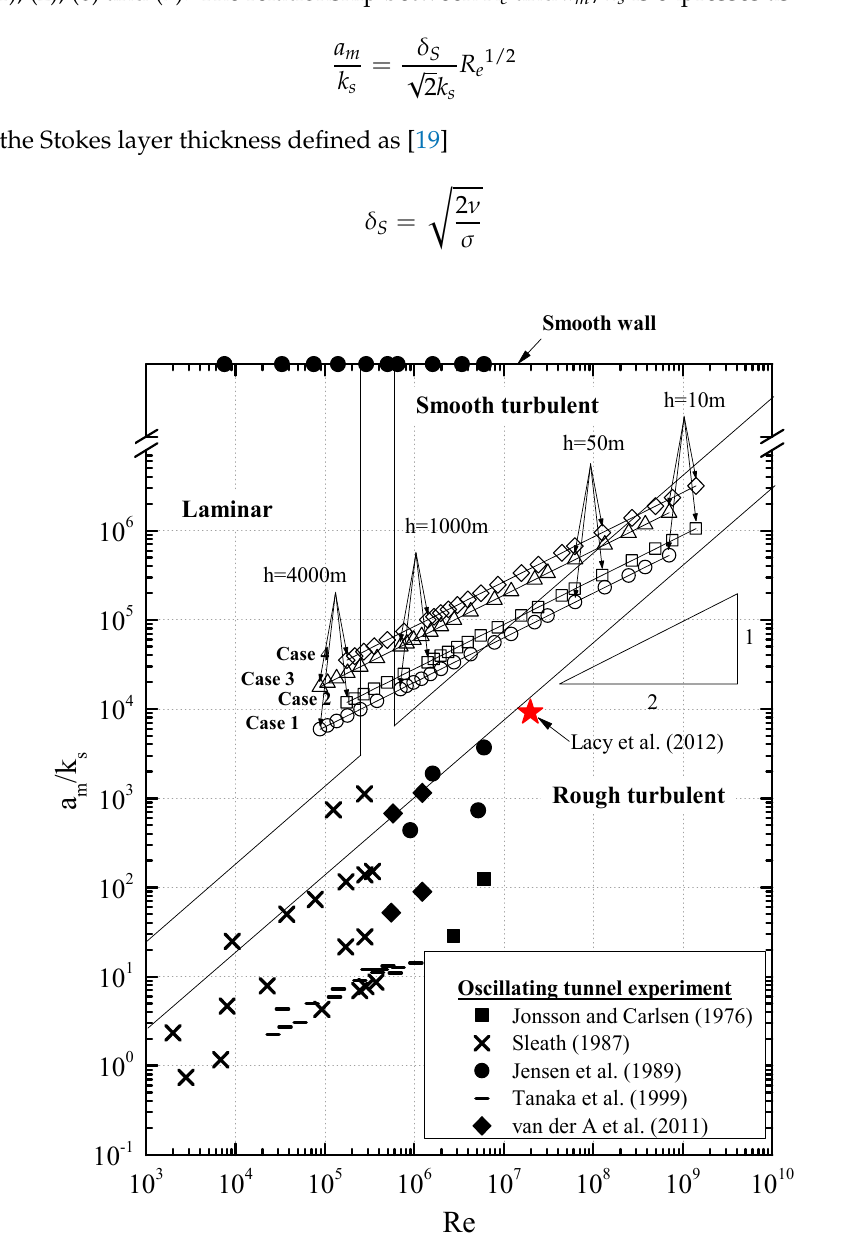
Figure 4. Flow regime under shoaling tsunamis and oscillating tunnel experiments.